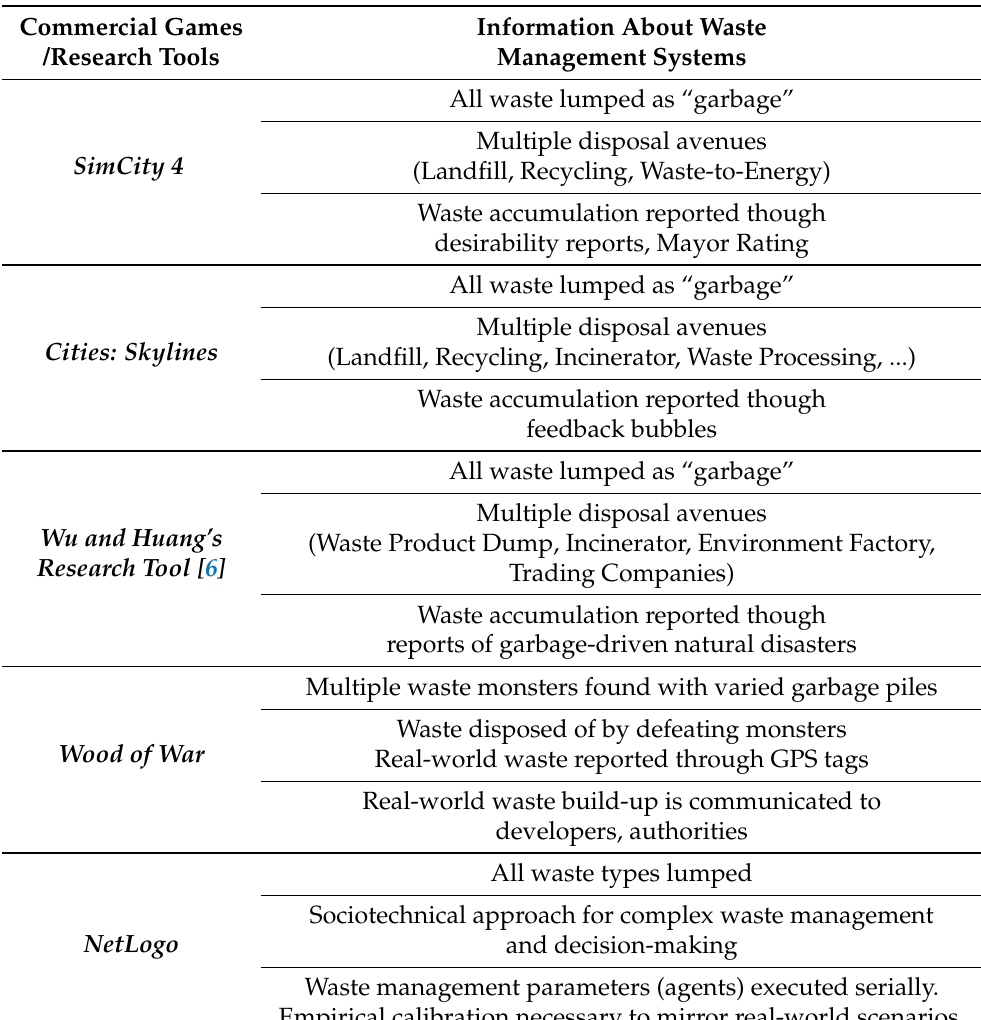
Table 1. Comparison of waste grouping, disposal methods, notification methods, and use cases for Waste Management Systems in Gamified Tools and Commercial